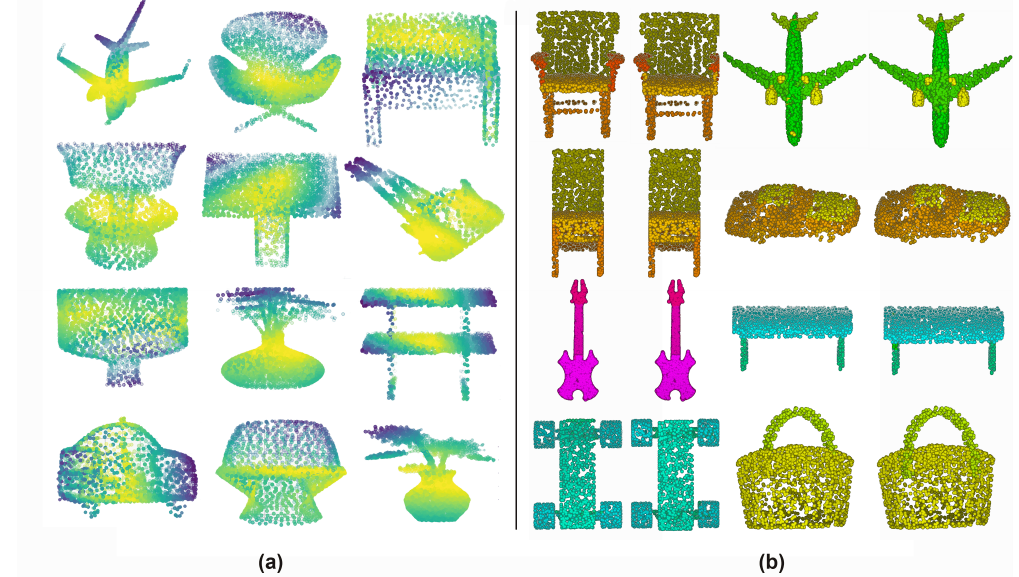
Figure 5. ( a ) Visualization of the attention mask on several point clouds of ModelNet40 dataset. The color changed from dark to light represents the weight from 1 to 0. ( b ) Visualization of part segmentation results on ShapeNet. We visualize some part segmentation results on ShapeNet across several categories. The left of each pair is the prediction of our model and the right is the groundtruth.